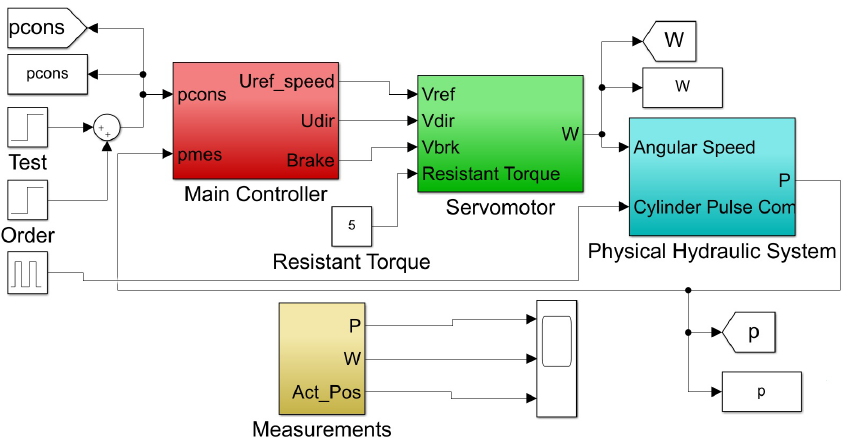
Figure 10. Mathematical model